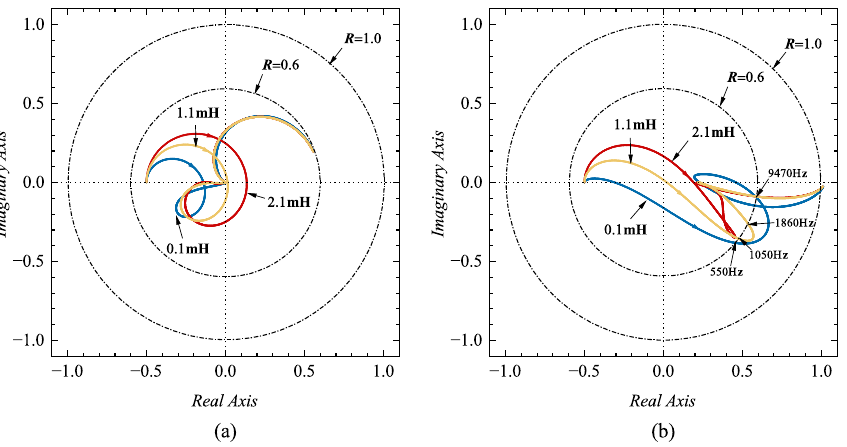
Figure 6. Nyquist curves of T ( z ) when grid-side inductance varies. ( a ) IIR filter. ( b ) FIR